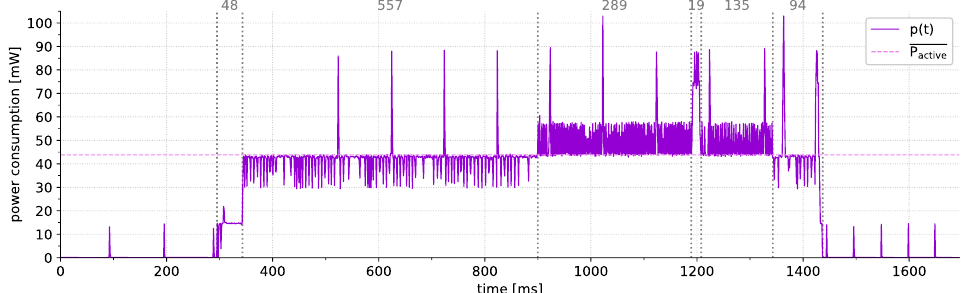
Figure 14. Current consumption in and duration of the active